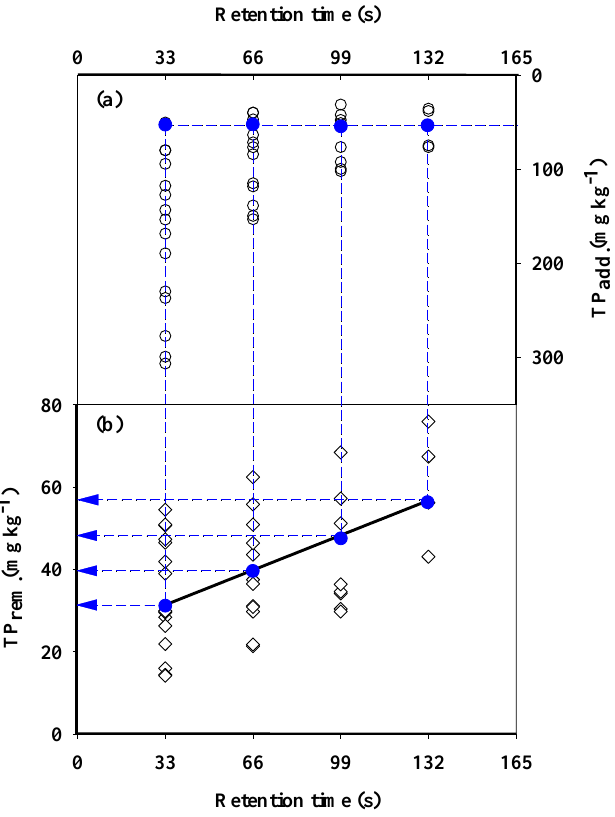
Figure 5. Total phosphorus (P) added (TP add ) and corresponding total P removed (TP rem ), as a function of retention time when considering all segment lengths. Blue circles indicate TP add and corresponding TP rem when a TP add 50 mg kg −1 , as described in the text.